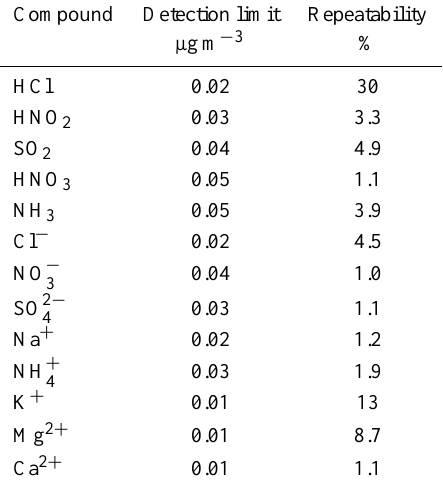
Table 1. The detection limits and the repeatability calculated from real air samples collected using the two parallel sample boxes of